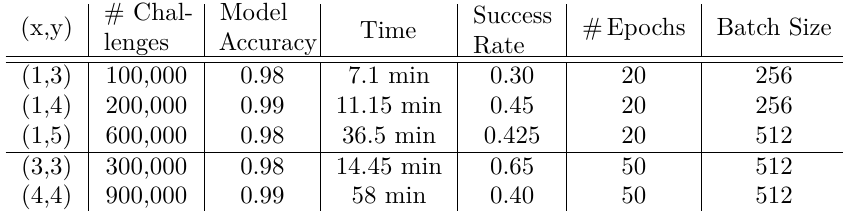
Table 4: Simulation results for LR, without reliability information, on noise-free iPUFs. For each instance size, 20 PUF instances were attacked with four trials